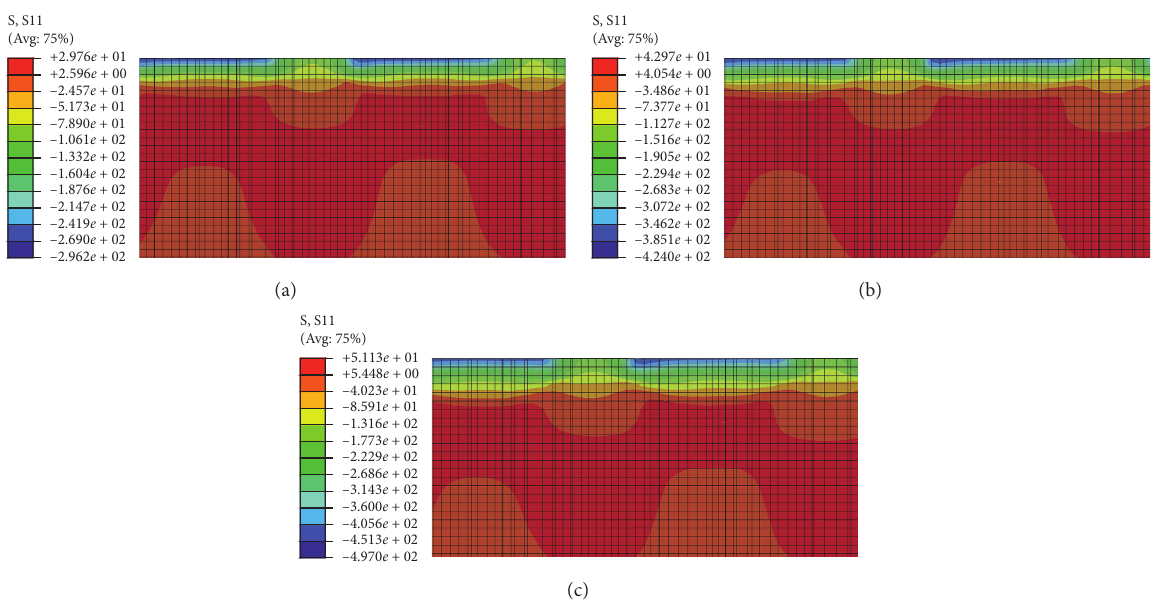
Figure 12: Contours of residual stress distribution of the in-depth direction of sample surface with different number of shocks. (a) 1 shock, (b) 2 shocks, and (c) 3 shocks.